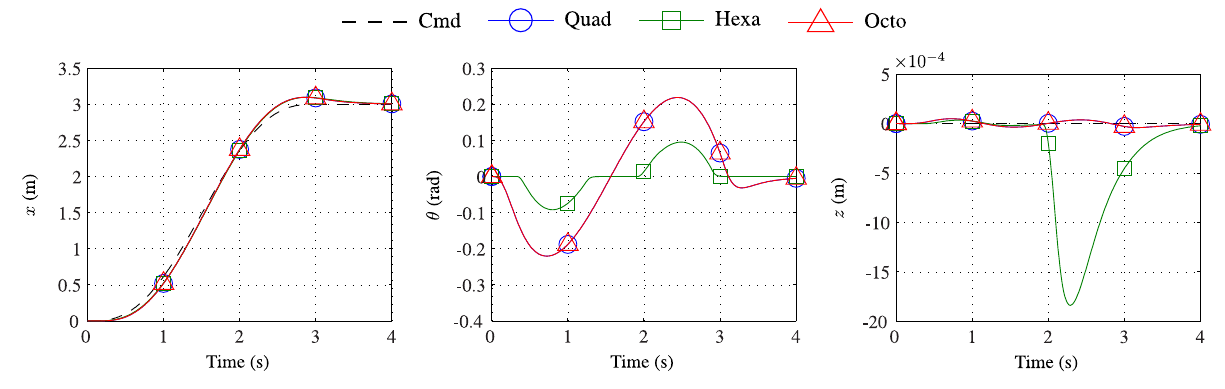
Figure 11. Dynamic response in longitudinal outputs for each multirotor when performing a fast horizontal translation in x